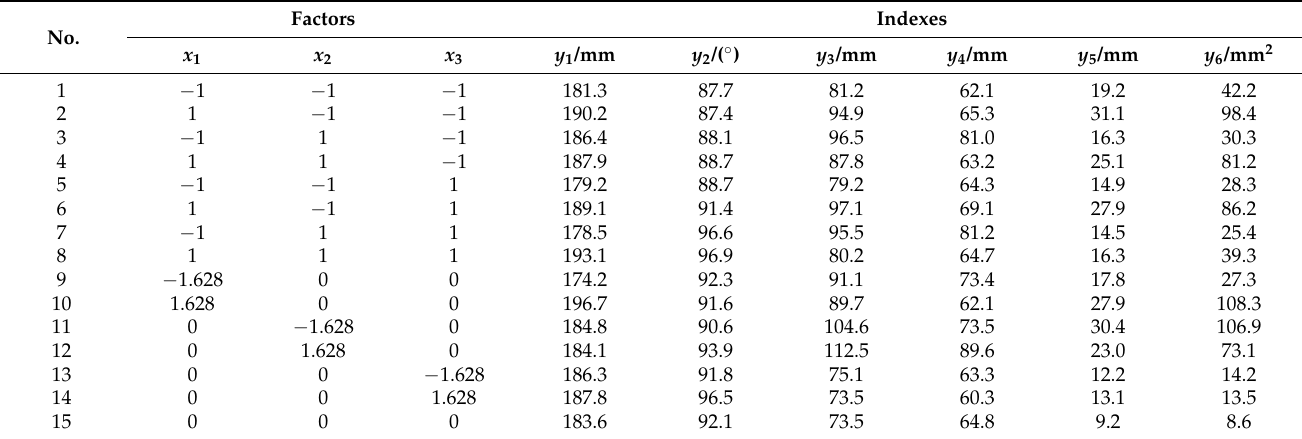
Table 6. Experimental plan and results.